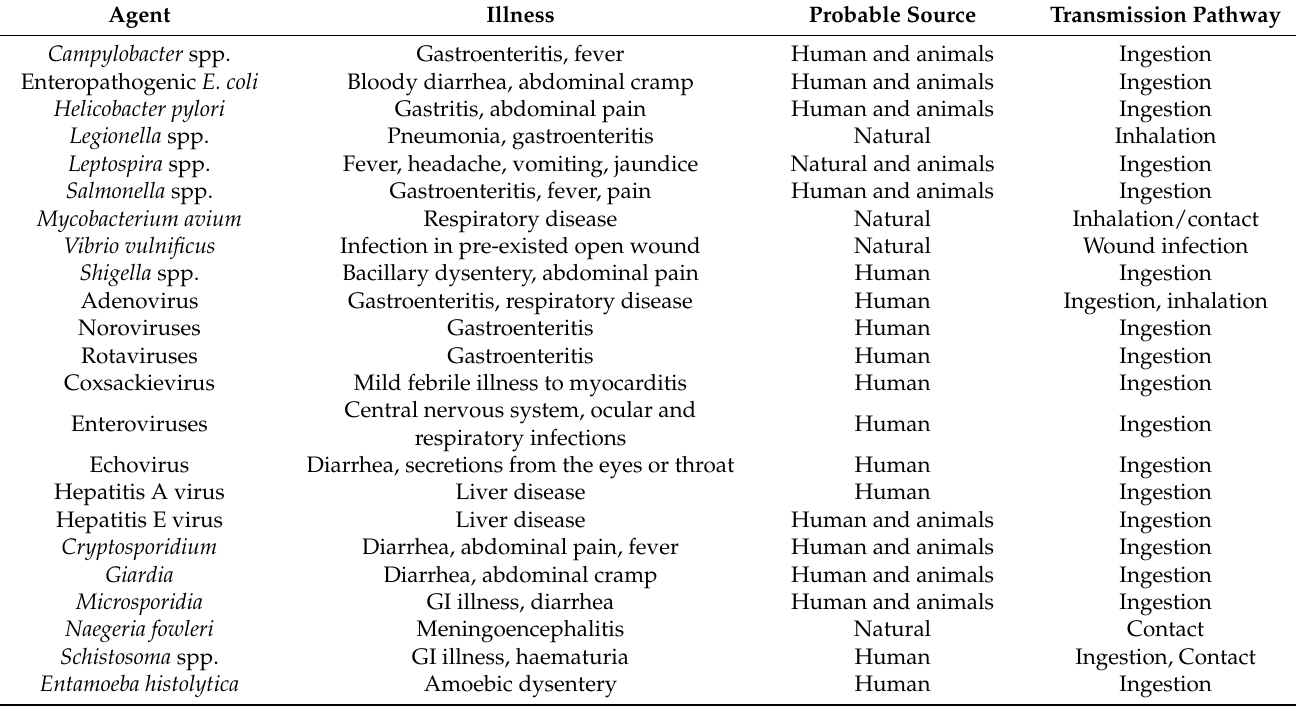
Table 1. Etiological agents of bathing illness, probable sources and transmission pathways. GI = gastrointestinal [7,19]. Agent Illness Campylobacter